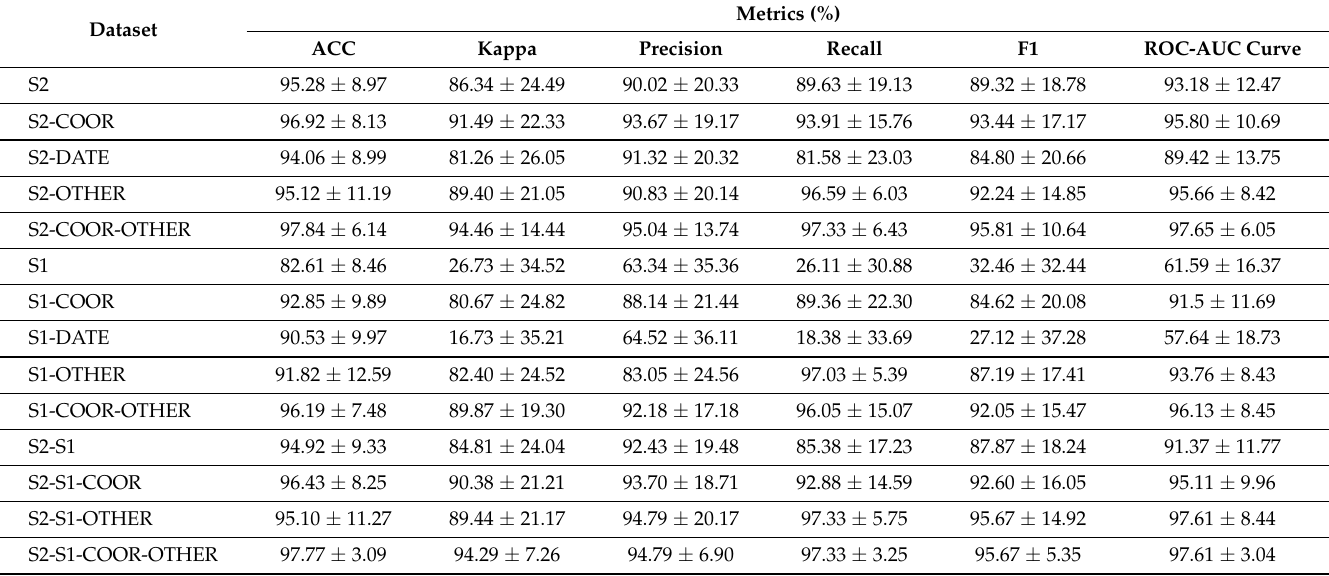
Table 5. Metrics obtained by Random Forest for each of the generated